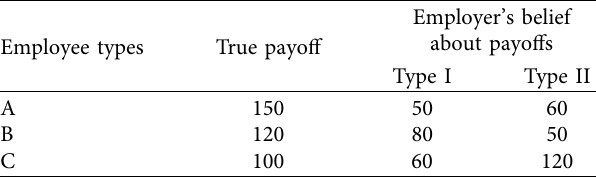
Table 1: An example of SCBB in the context of hiring. Employee